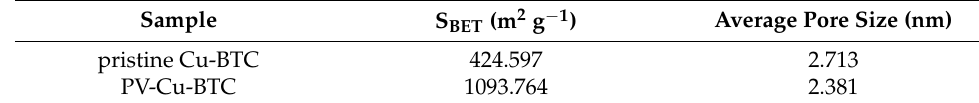
Table 2. Texture structure parameters of pristine Cu-BTC and PV-Cu-BTC.